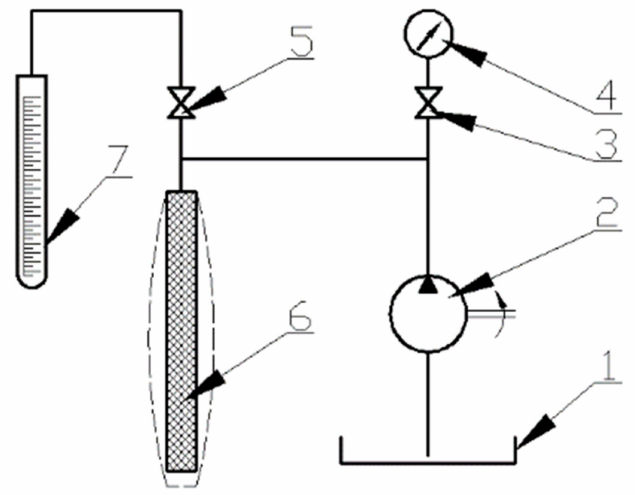
Figure 6. Schematic diagram of a laboratory stand for hydraulic hoses internal volume expansion: 1—tank; 2—manual pump; 3,5—cut-off valves; 4—pressure sensor ∆ p i of the fluid; 6—tested hy- draulic hose; 7—measurement